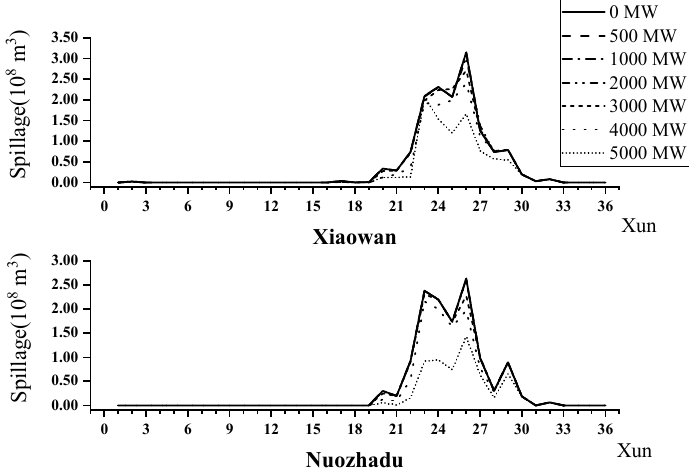
Figure 7. The average spillage in each Xun under different power yields.